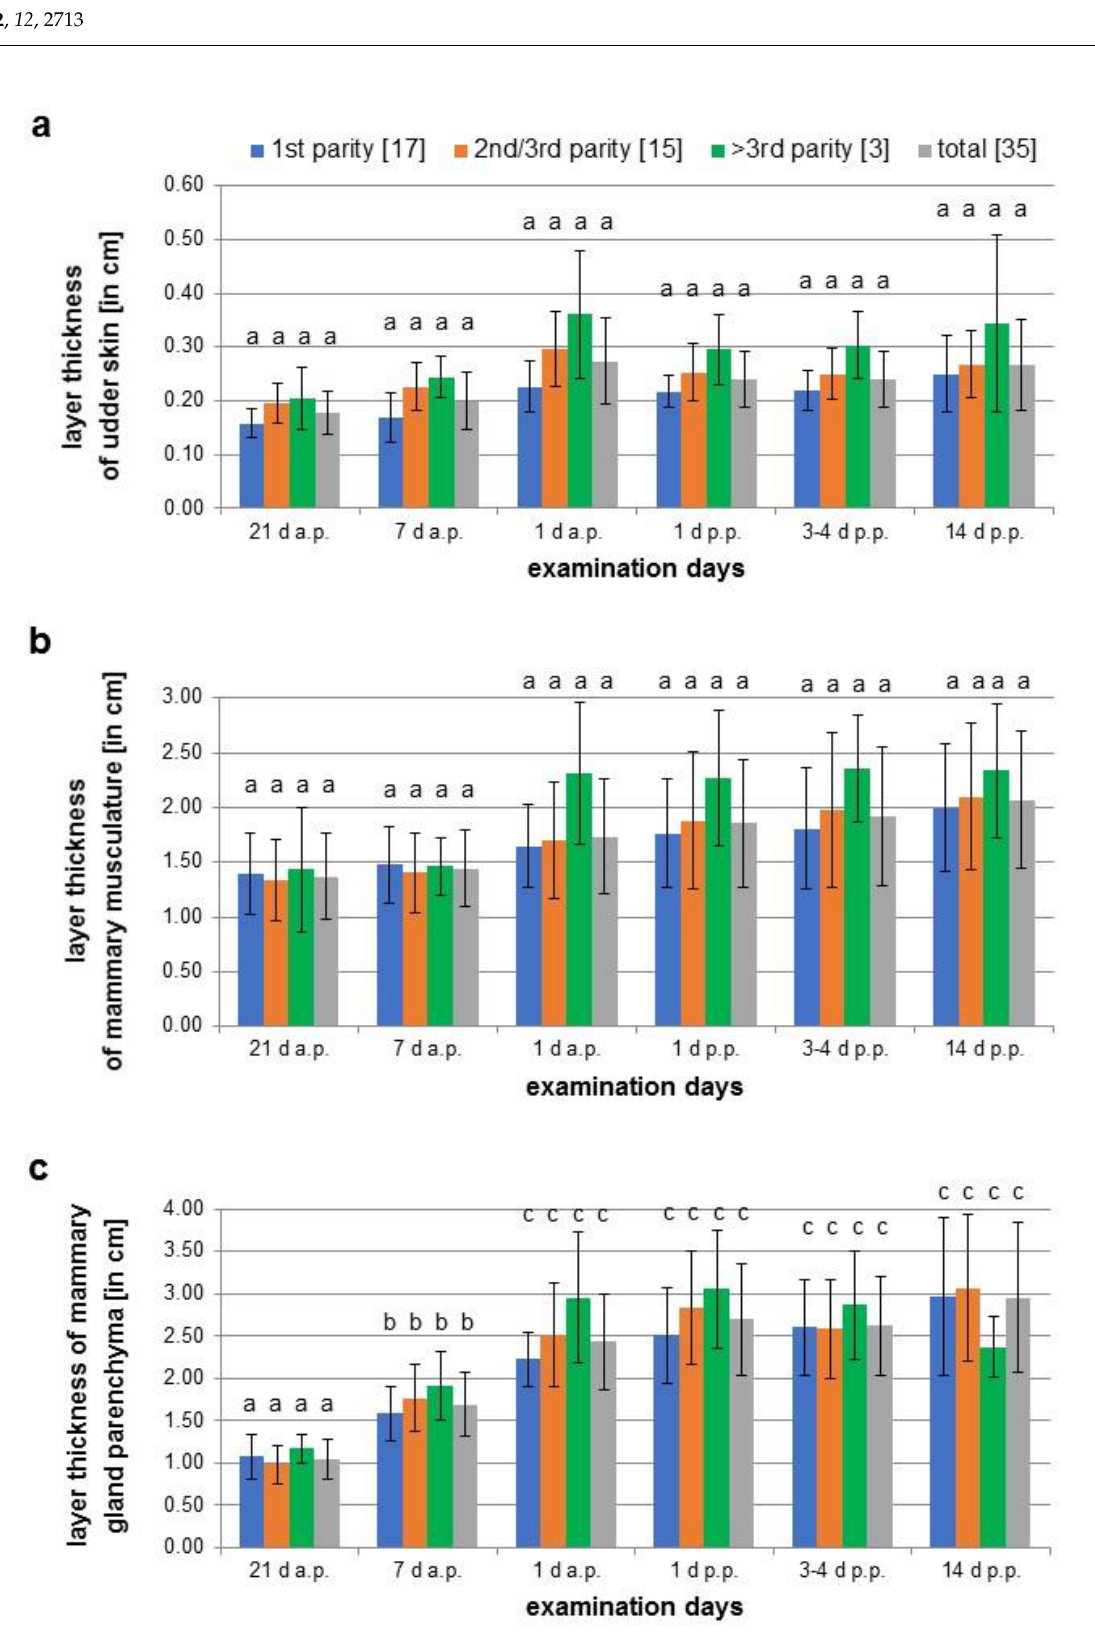
Figure 5. Measurements of the layer thickness of the udder skin ( a ), muscle layer ( b ) and mammary gland parenchyma ( c ) of three sow groups during different parities (1st parity, 2nd/3rd parity, >3 parity) on six different examination days (21 d a.p., 7 d a.p., 1 d a.p., 1 d p.p., 3–4 d p.p., 14 d p.p.); different letters show significant differences between the age groups and the time of examination ( p <